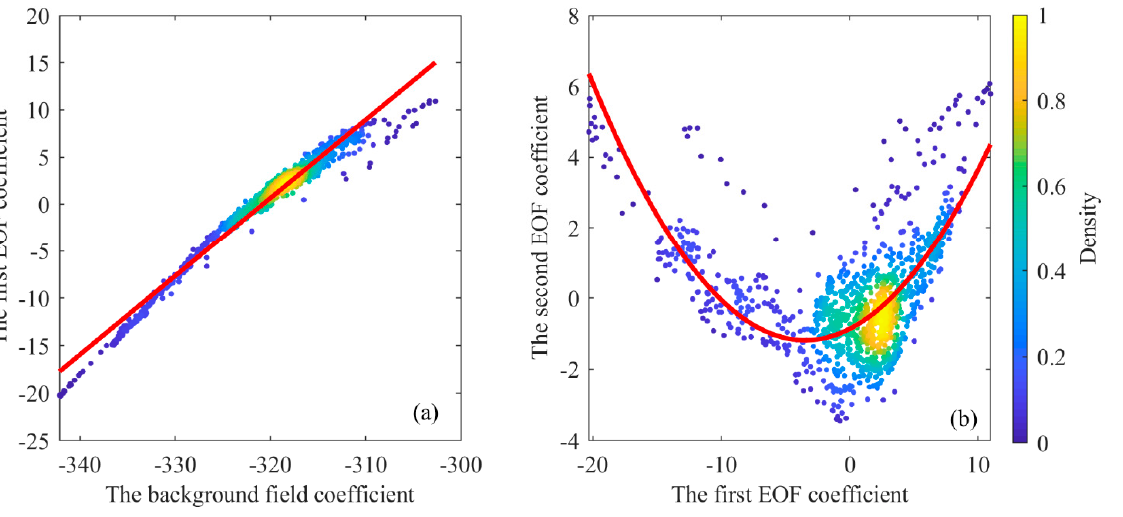
Figure 7. Statistical characteristics of background field coefficient and the first two EOF coefficients. ( a ) The scatter diagram and fitted line of the background field coefficient and the first EOF coefficient, ( b ) the scatter diagram and fitting curve of the first EOF coefficient and the second EOF